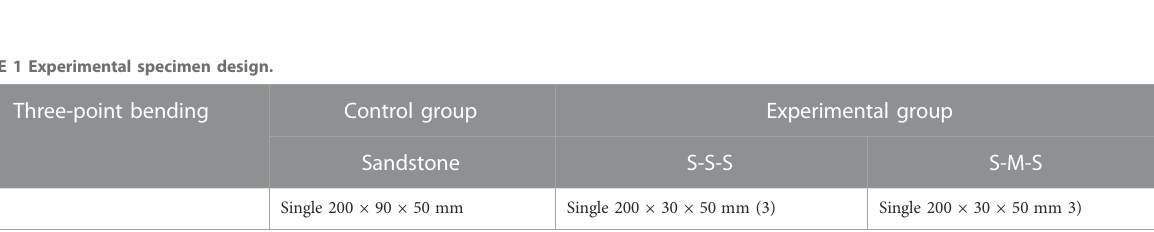
TABLE 1 Experimental specimen design.